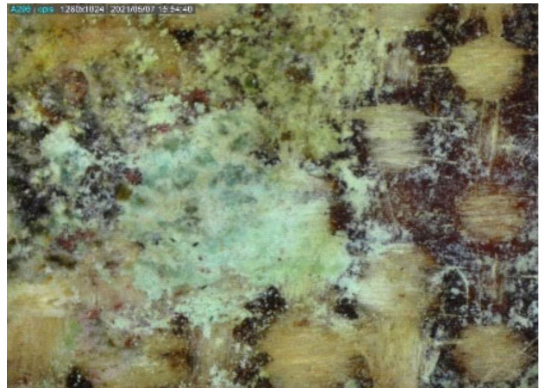
Figure 20. MO image of the surface of a textolite material with a greenish deposit of copper com- pounds and very strong degradation effects (magnified 40 times). Strong charring of resin residues on the surface of the sample material is